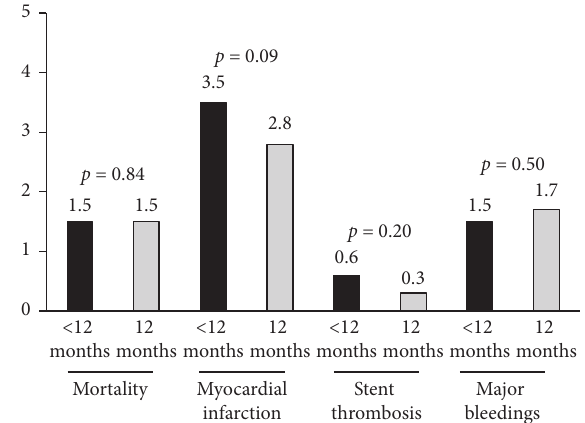
Figure 1: Bar graph showing the rate of major clinical events in clinical trials comparing 12-month dual antiplatelet strategy (DAPT) vs. a shorter strategy followed by ASA alone.